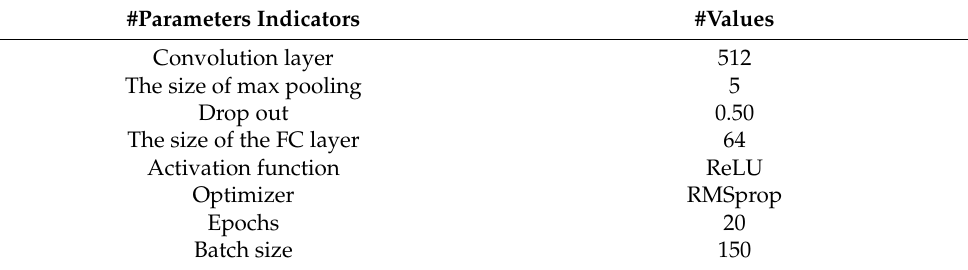
Table 3. Using parameters of CNN–LSTM algorithm for detecting